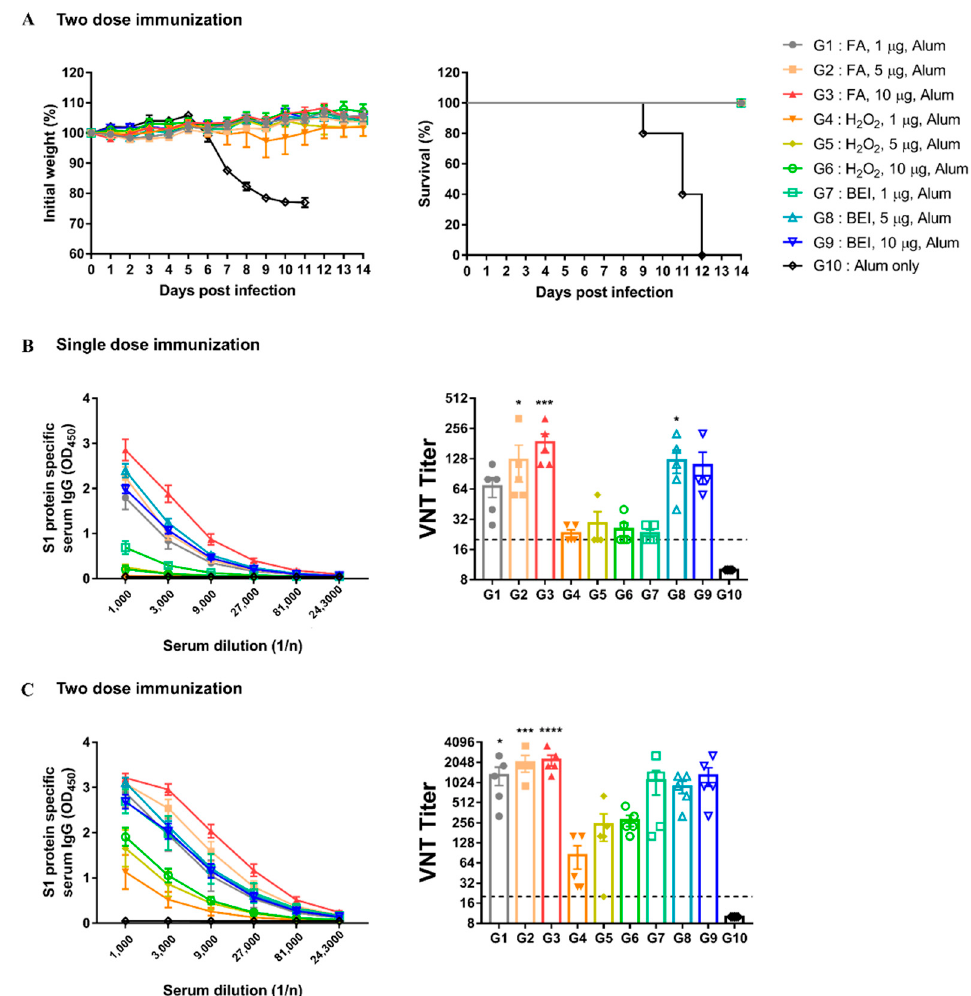
Figure 4. Inactivated-MERS-CoV by formaldehyde has higher protective effect for MERS-CoV than H 2 O 2 and BEI. ( A ) Changes in body weight and survival rate for 2 weeks when infected with the virus after two dose immunization. The survival symbols of G2 to G9 overlapped with G1. ( B ) MERS-CoV S1 protein-specific serum IgG levels and nAbs were measured by ELISA and VNT. Serum was collected 2-weeks after single dose immunization. ( C ) MERS-CoV S1protein-specific serum IgG levels and nAbs after two dose immunization. Data are represented as the mean ± S.E.M. * p < 0.05, *** p < 0.001, **** p < 0.0001 compared with G10 (Alum only).